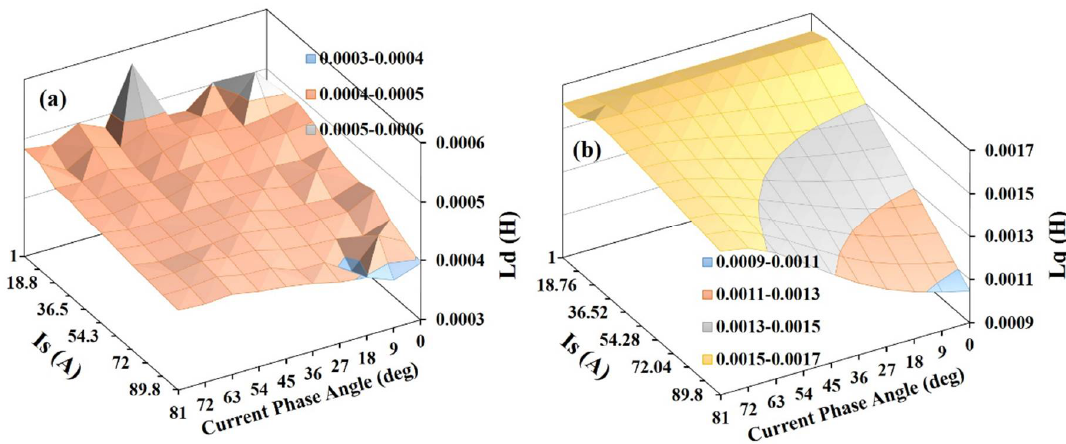
Figure 5. d-q- axis inductance of double-layer PM IPMSM: ( a ) L d , ( b ) L q .